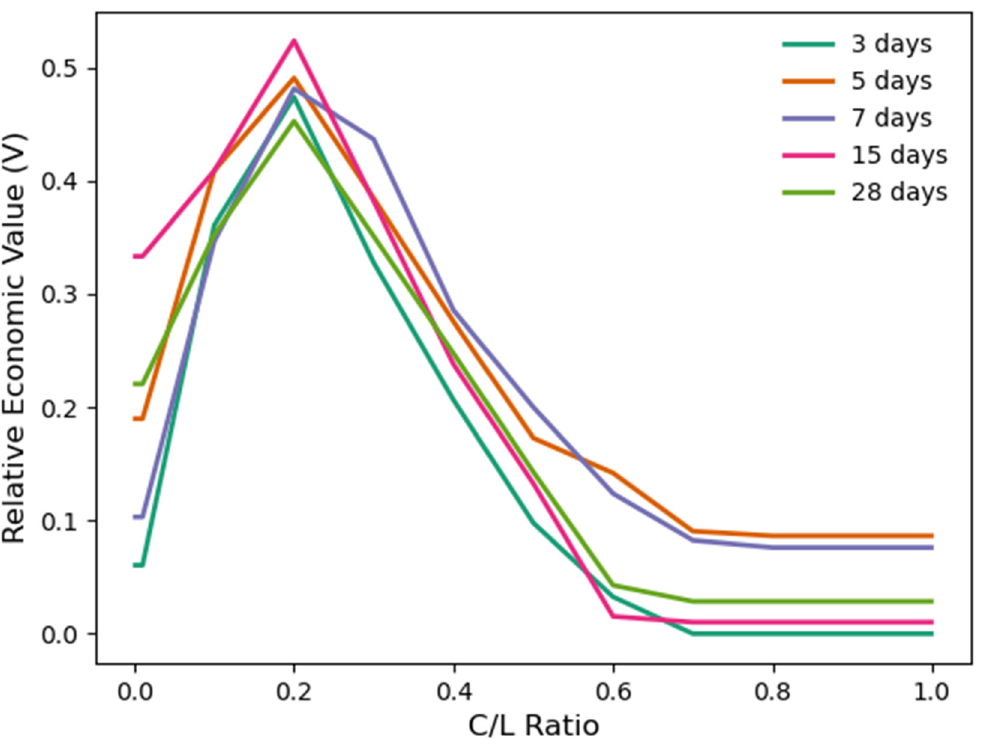
Figure 3. Relative Economic Value (vertical axis) for different cost/loss ratios (horizontal axis) and forecast intervals of 3 to 28 days (coloured lines) estimated for water treatment maintenance planning (CS9).